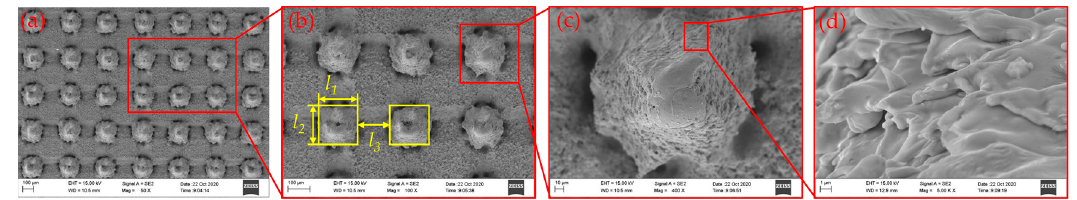
Figure 5. Scanning electron microscope (SEM) images of micro-nano structure: ( a ) 50 times magnification; ( b ) 100 times magnification; ( c ) 400 times magnification; ( d ) 5000 times magnification.